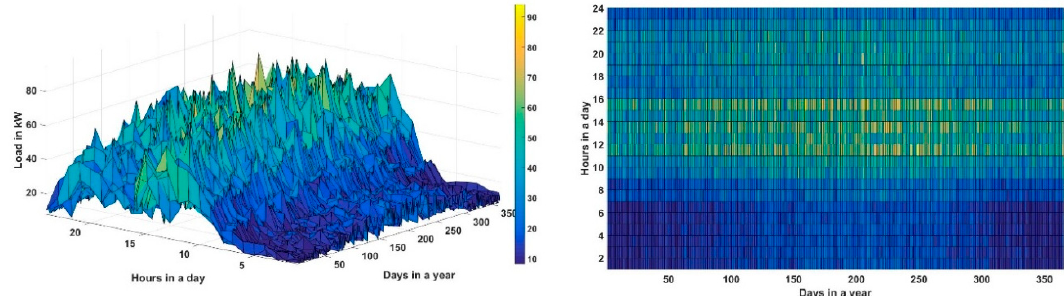
Figure 4. Daily and seasonal variations of primary load (in kW).